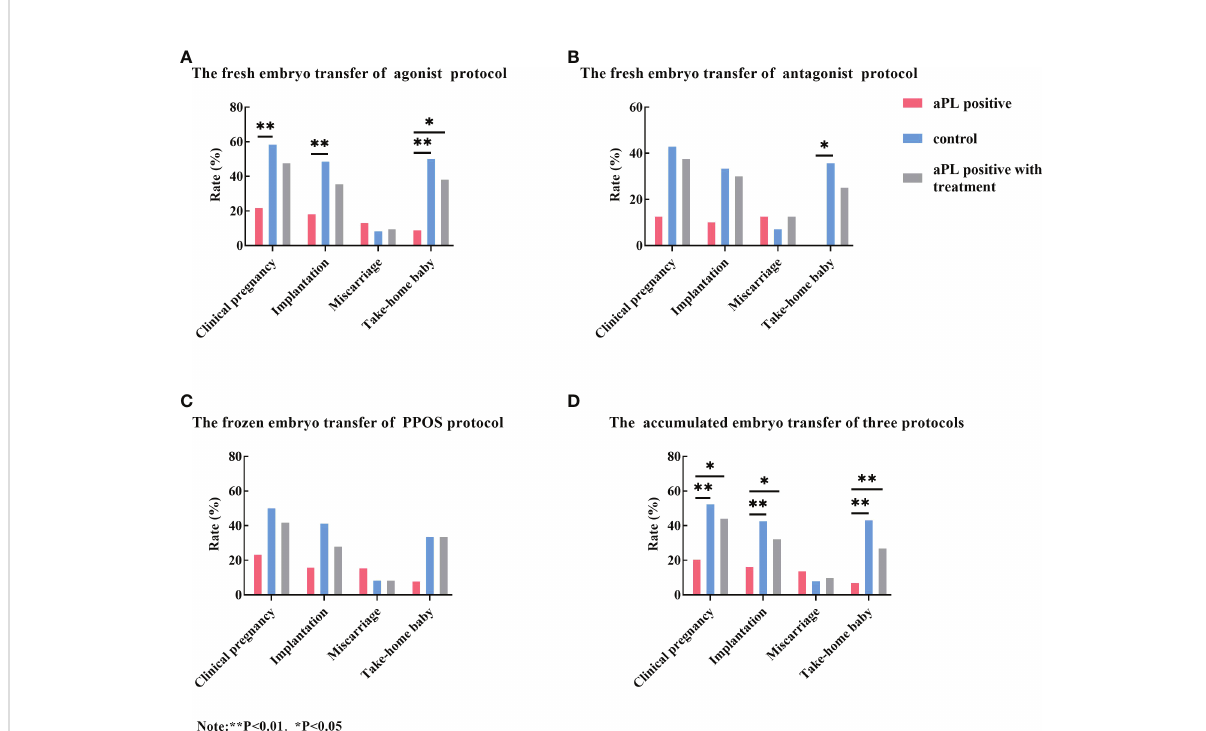
FIGURE 5 Comparison of the clinical pregnancy rate, implantation rate, miscarriage rate, and take-home baby rate among aCL and/or a b 2GP1 antibody (aPL) positive women without treatment (the aPL group), aPL negative women (the control group), and aPL-positive women with treatment (the aPL treatment group). Regardless of stimulation protocol, the clinical pregnancy rate, implantation rate, and take-home baby rates of the control and aPL treatment groups were higher than those of the aPL group. When comparing the total embryo transfer outcomes of three protocols, the clinical pregnancy rate, implantation rate, and take-home baby rate of the control and the treatment groups were signi fi cantly higher than those of the aPL group. However, the miscarriage rates were not different among the three groups. (A) The fresh embryo transfer outcomes of GnRH agonist protocol; (B) The fresh embryo transfer outcomes of GnRH antagonist protocol; (C) The frozen embryo transfer outcomes of PPOS protocol; and (D) The total embryo transfer outcomes of three protocols. **P<0.01,